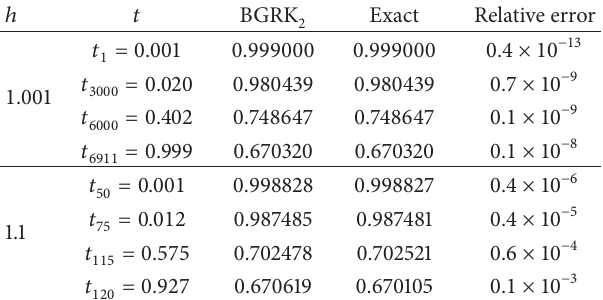
Table 3: Comparison of the results of the BGRK exact values and its relative